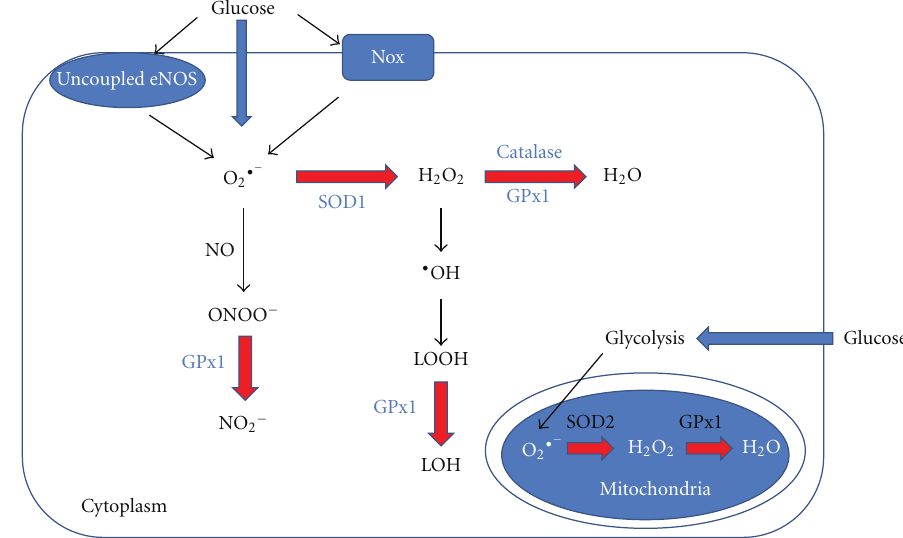
Figure 3: Classic antioxidant pathways for the neutralization of ROS produced by hyperglycaemia in the cytoplasm and mitochondria of endothelial cells. O 2 •− : superoxide anion; ONOO − : peroxynitrite; NO 2 − : nitrite; H 2 O 2 : hydrogen peroxide; • OH: hydroxyl radicals; LOOH: lipid hydroperoxides; LOH: lipid alcohol; Nox: NADPH